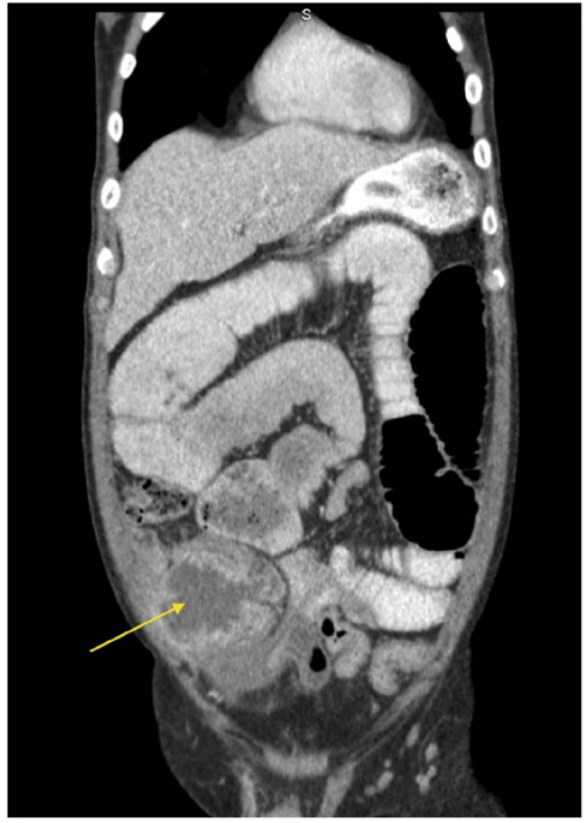
Figure 6d: Coronal CT showing marked small bowel obstruction secondary to a tumour in the right iliac fossa (arrow)